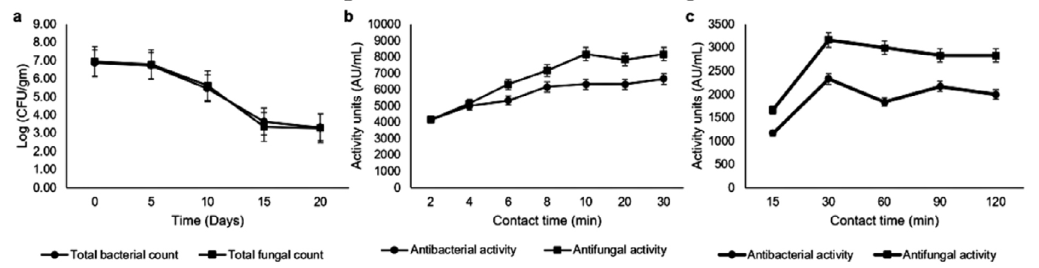
Fig. 5. Evaluation of LPE+Nisin for cardboard preservation a. Reduction in microbial count of treated cardboard b. Binding of LPE+Nisin to cardboard surfact at different contact times c. Release of LPE+Nisin from the cardboard surface at different